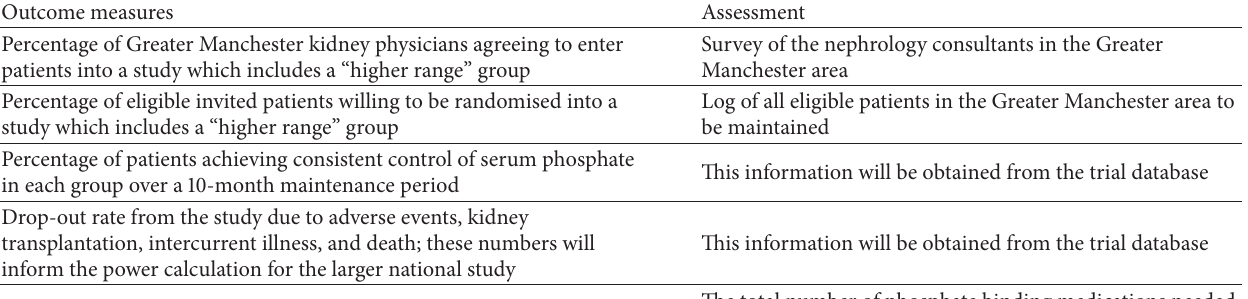
Table 5: Measuring trial